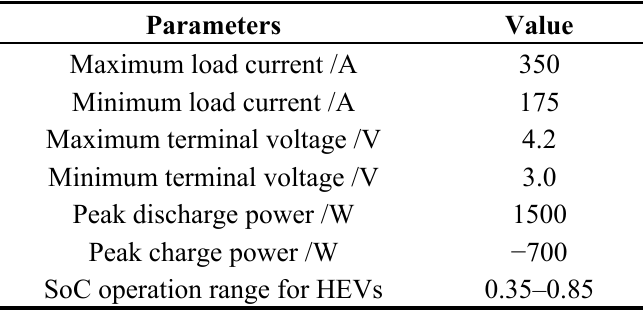
Table 1. The cell’s design limits for the HIL test.